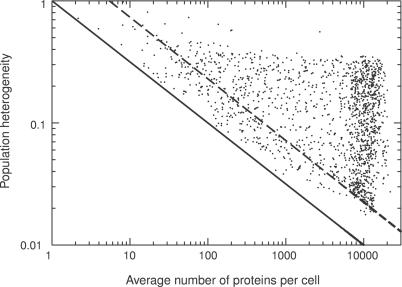
Population Heterogeneity Can Be Lower Than the Intrinsic NoiseOne promoter function is placed in a well-mixed environment; therefore, both genetic and spatial heterogeneity are absent. Dashed line, intrinsic noise (from Figure 1):
, with P the number of proteins in the cell. Solid line, Poisson noise:
.